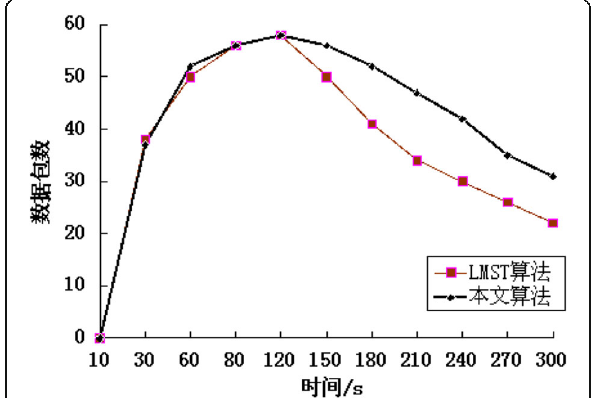
Fig. 3 Comparison of throughput curve between LMST algorithm and this